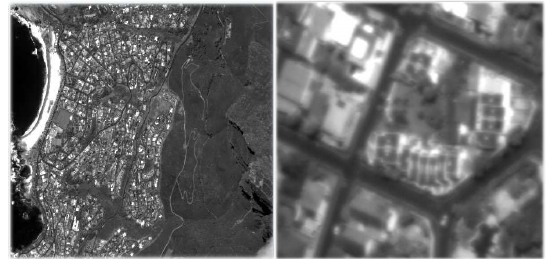
Figure 13. Example of Cape Town defocused image.